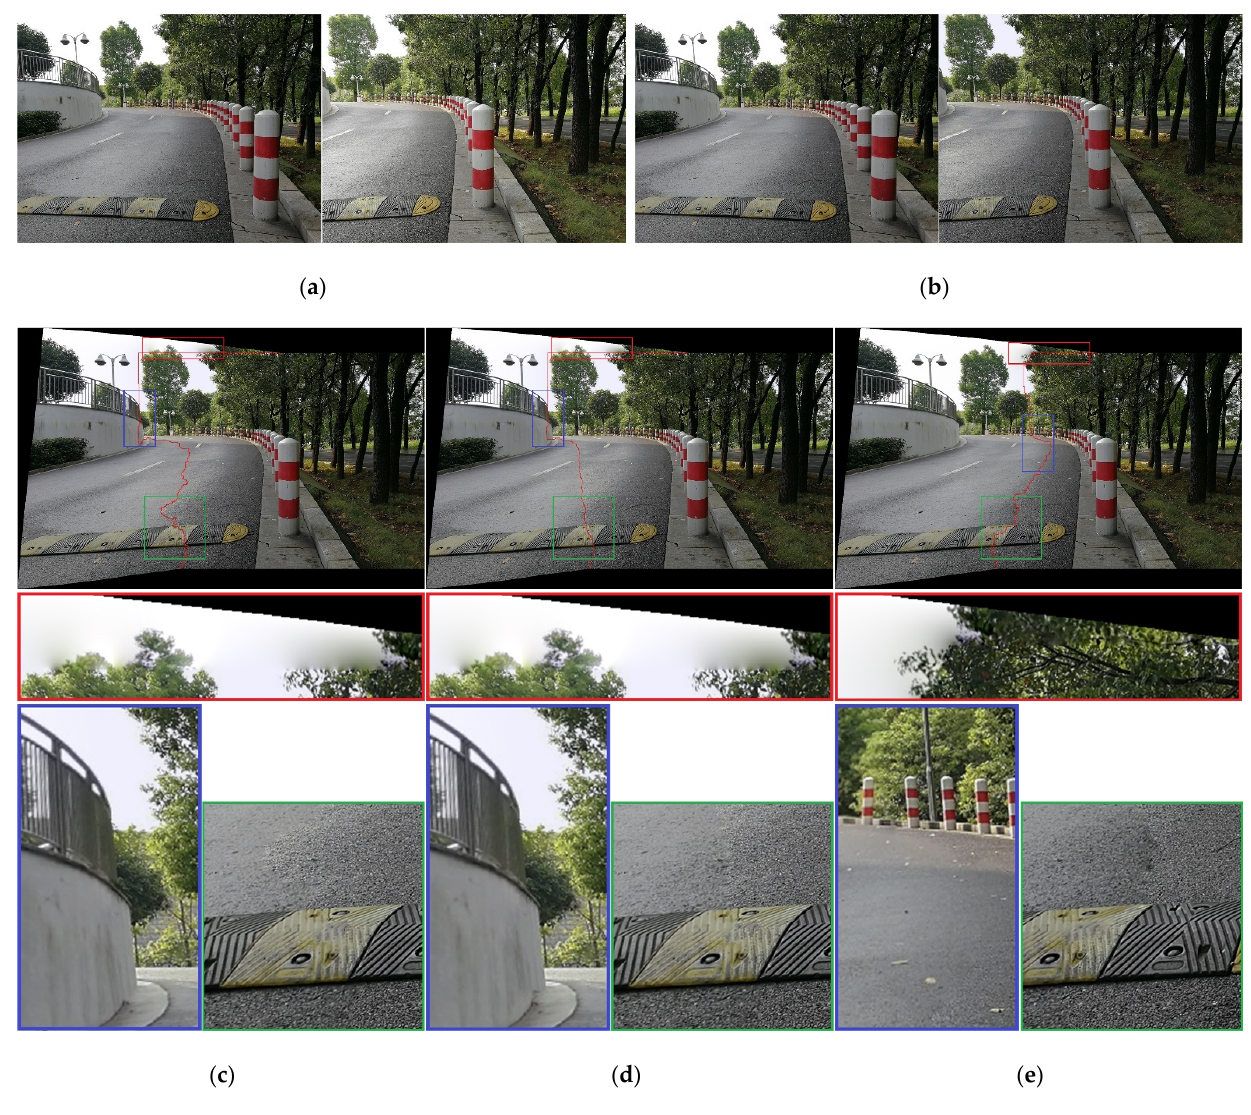
Figure 9. Image stitching results after brightness correction. ( a ) The original images to be stitched. ( b ) Images after brightness correction with the method in [29]. ( c ) The perceptual seam-cutting method [18]. ( d ) The traditional seam-driven method based on color and texture information. ( e ) The proposed method.